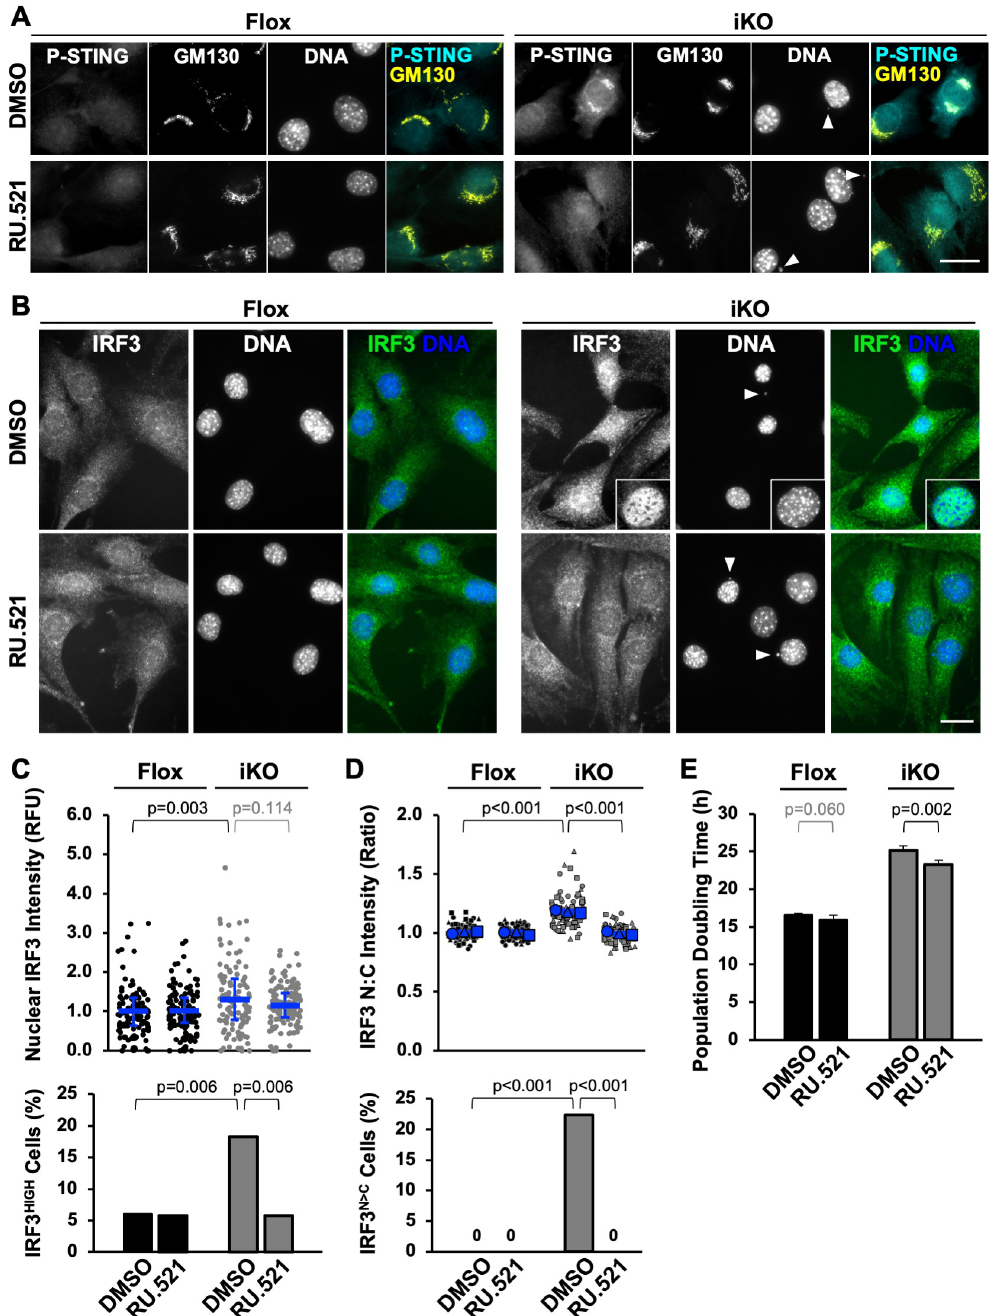
Fig 11. cGAS-associated activation of STING-IRF3 signaling affects the proliferation arrest of ArpC2-deficient cells. (A) Mouse fibroblasts were treated with DMSO (Flox) or 4-OHT (iKO) for 3d, switched to media containing DMSO or RU.521, fixed at 6d, and stained with antibodies to Phospho-serine365 of STING (P-STING; cyan) and GM130 (yellow), and with DAPI (DNA; blue). Arrowheads point to micronuclei. Scale bars, 25 μ m. (B) Cells were treated as in A and stained with IRF3 antibodies (green) and DAPI. The intranuclear staining pattern of IRF3 is highlighted in a magnified inset. (C) Nuclear IRF3 fluorescence was quantified by outlining the DAPI-stained nucleus of each cell in ImageJ and measuring the mean IRF3 pixel intensity. Each dot represents an individual cell and the blue lines represent the mean intensities from analyses of n = 104– 120 cells pooled from 3 experiments. RFU = Relative Fluorescence Units. IRF3 highly-expressing (IRF3 HIGH ) cells were defined as those with nuclear expression levels > 2-fold higher than the mean nuclear IRF3 fluorescence of Flox cells. (D) The ratio of nuclear (N) to cytoplasmic (C) IRF3 fluorescence intensity was quantified. Each dot represents an individual cell,